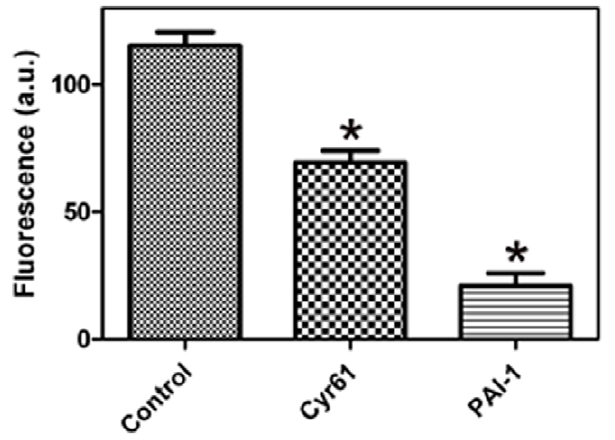
Figure 5. Competitive ELISA. Indicated concentrations of native monomeric VTNC, heat-modified monomeric VTNC, multimeric VTNC, SMTB 1–44 , or ixolaris were co-incubated with a constant concentration of Cyr61 (30 nM) on microtiter wells coated with multimeric VTNC. The binding of Cyr61 to immobilized VTNC was detected with anti-Cyr monoclonal antibody followed by alkaline phosphatase-labeled anti- mouse secondary antibody and appropriate substrate as described in Materials and Methods. Results were from quadruplicate experiments.